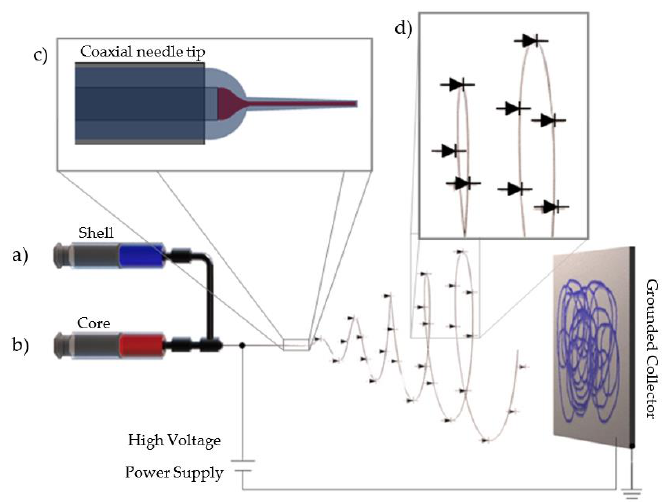
Figure 2. Coaxial nanofiber with p- and n-type semiconducting polymers. This nanofiber provides an opportunity to form p-n junctions that can be tethered for electroactive textiles and single- nanofiber devices.